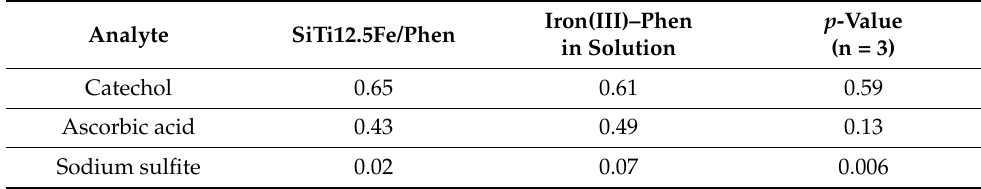
Table 4. Gallic acid equivalent antioxidant capacities for the antioxidants determination in solution and using